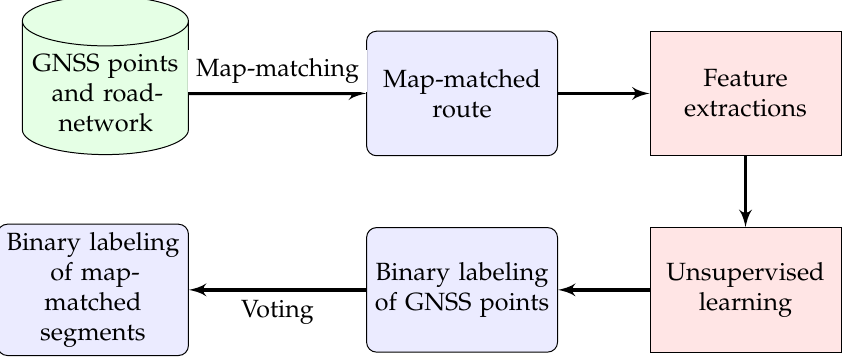
Figure 6. Step 1 of the proposed methodology for map-matching error